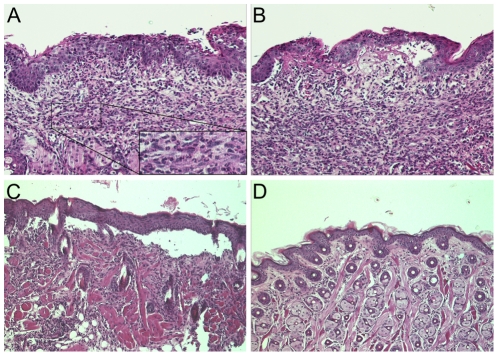
Dermal-epidermal separation in mice injected with BP180/CXVII-specific antibodies.Skin biopsies from mice pre-sensitized with rabbit IgG and subsequently injected with rabbit IgG were stained with hematoxylin and eosin. (A) Dense inflammatory infiltrates dominated by granulocytes in a BALB/c mouse receiving BP180/CXVII-specific IgG; (B) Subepidermal split and dense inflammatory infiltrates dominated by granulocytes; (C) Extensive dermal-epidermal separation; (D) Normal histological appearance in a control mouse receiving normal rabbit IgG (magnification, ×400).